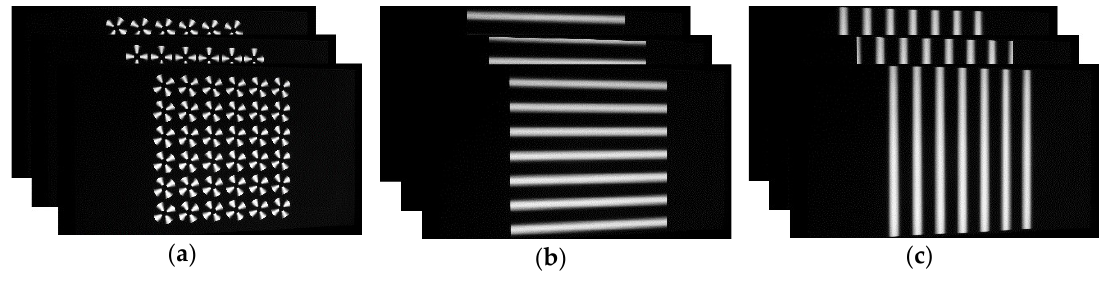
Figure 7. The captured images of different phase-shifting patterns. ( a ) three-step PWG arrays; ( b ) three-step horizontal phase-shifting fringe patterns; and, ( c ) Three-step vertical phase-shifting fringe patterns.